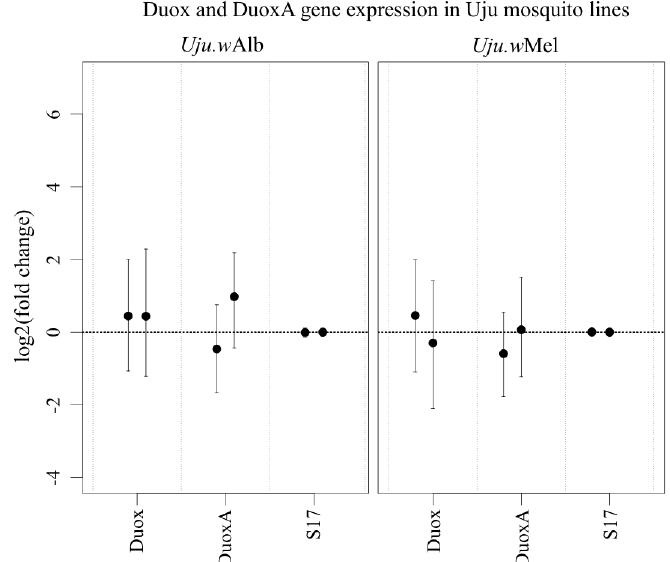
Figure 5. Transcription of Duox and DuoxA in Uju. w Alb and Uju. w Mel adult females, normalised to S17 transcription and to uninfected Uju.T. Points represent mean of 3–5 pools of three females and error bars denote Bayesian 95% credible intervals. Each bar within a gene category represents an independent experiment.